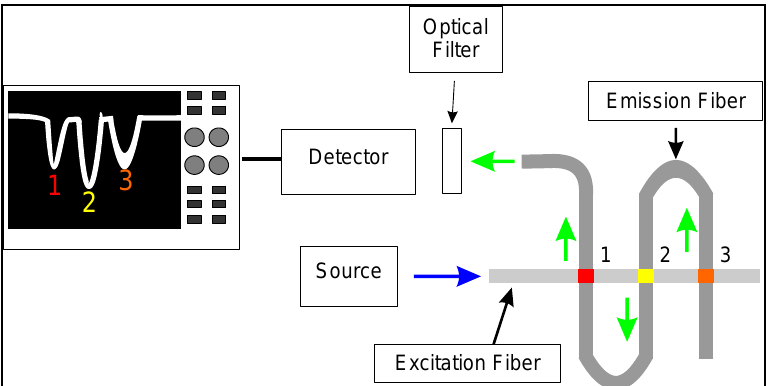
Figure 1. A schematic depicting the experimental design of a crossed-fiber sensor array containing three sensor junctions (labeled 1, 2, and 3). The blue arrow indicates the excitation pulse and the green arrows indicates a fluorescence